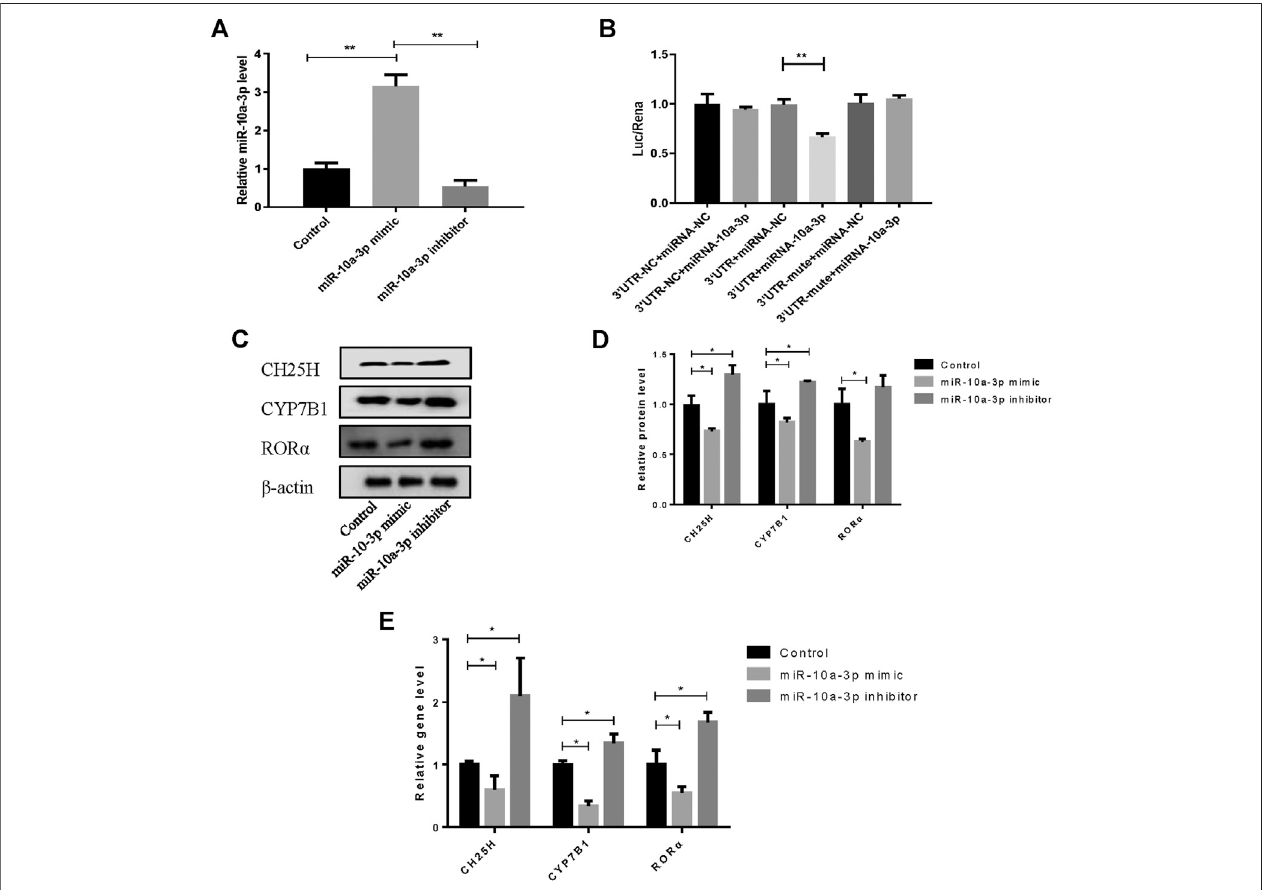
FIGURE 3 | MiR-10a-3p can bind with the 3 ′ UTR of CH25H. (A) Transfection ef fi ciency of miR-10-3p inhibitor and mimic were detected by qRT-PCR ( n (cid:1) 3). The quantitativedataarepresentedasthemean ± SD. (B) TherelativeluciferaseactivitywasmeasuredafterHEK-293Tcellswereco-transfectedwiththewildtypeormutant 3 ′ UTR ofCH25H luciferase reporter and the miR-10-3p negative controlor mimic ( n (cid:1) 3). (C , D) CH25H, CYP7B1 and ROR α expression in chondrocytes were analyzed via western blotting. The band intensity was quanti fi ed by normalizing to β -actin ( n (cid:1) 3). (E) CH25H and CYP7B1 expression in chondrocytes were analyzed via qRT-PCR. Quantitative data were presented as mean ± SD. * p < 0.05, ** p <